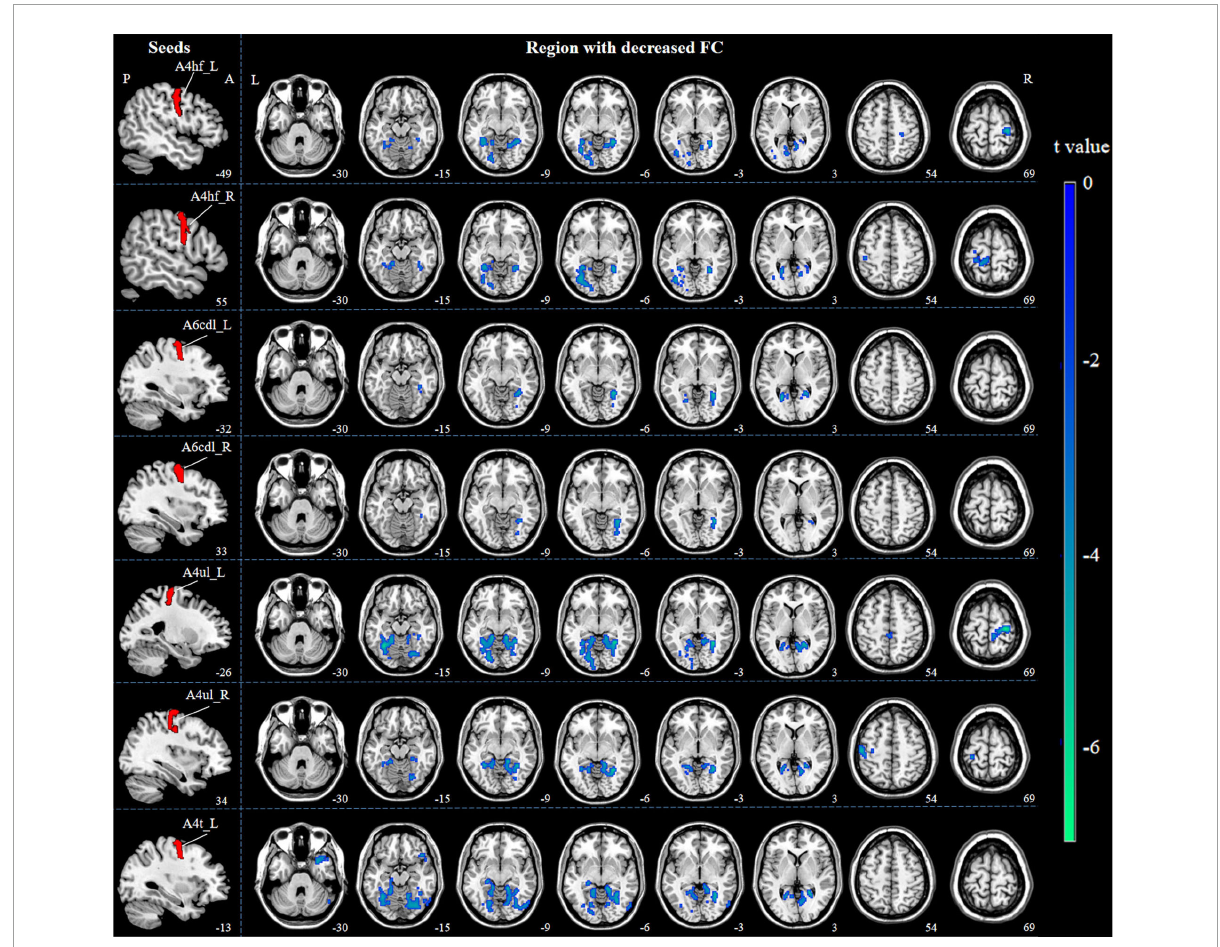
FIGURE3 Decreased FC between M1 subregions and the whole brain in ICCI patients. Compared with HCs, ICCI patients demonstrated decreased FC in bilateral LG, left FG and right PSMC when the seed was located in the left A4hf, as well as decreased FC in bilateral FG and left PSMC when the seed was located in the right A4hf. Moreover, ICCI patients showed decreased FC between the left A6cdl and right LG, left CG, as well as decreased FC between the right A6cdl and right FG. In addition, decreased FC between the left A4ul and bilateral FG, right PSMC as well as decreased FC between the right A4ul and left LG, PSMC, right FG was also found in ICCI patients. Besides, when the seed was located in the left A4t, ICCI patients demonstrated decreased FC in right TP, LG and left FG [corrected at cluster level with family wise error (FWE) P < 0.05 and cluster size > 75]. FC, functional connectivity; M1, primary motor cortex; ICCI, incomplete cervical cord injury; HCs, healthy controls; LG, lingual gyrus; FG, fusiform gyrus; PSMC, primary sensorimotor cortex; CG, calcarine gyrus; TP, temporal